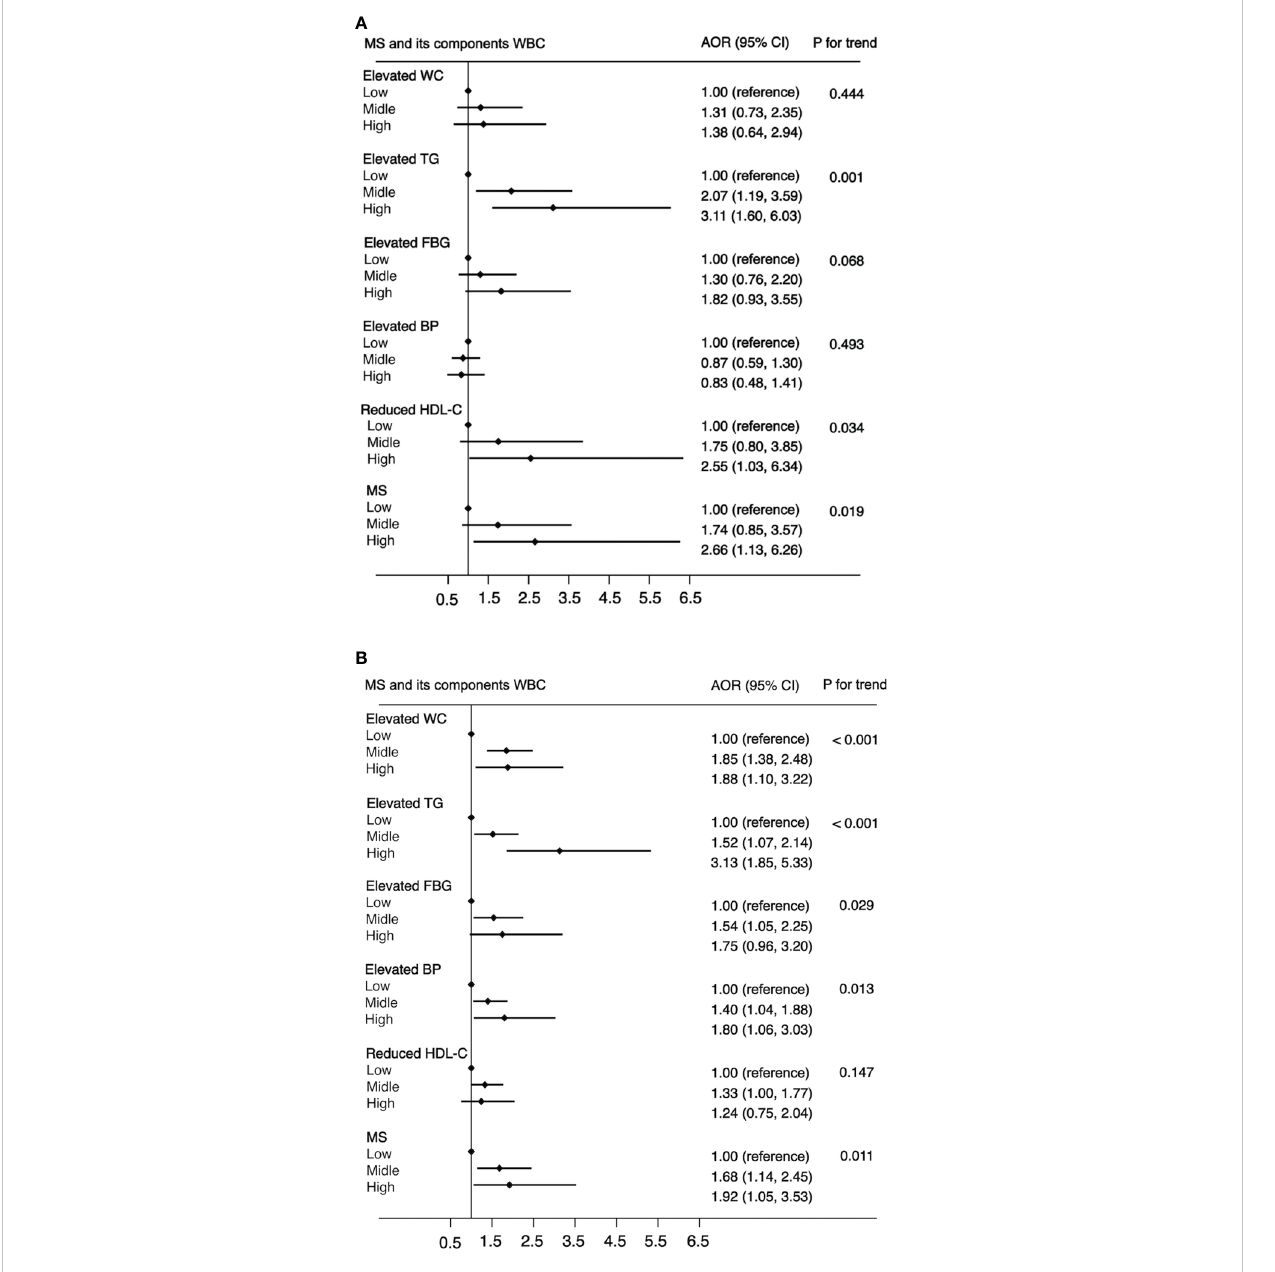
FIGURE 2 The association between WBC and risk of MS in male (A) and female (B) . Adjusted for age (<=39, 40-64, >=65), BMI (<25, >=25 & <30,>=30), residence (city, suburb, town or rural village), smoking (smoker or non-smoker) and drinking status (drinker or non-drinker), HOMA-IR (yes or no). Data are shown as OR and 95%